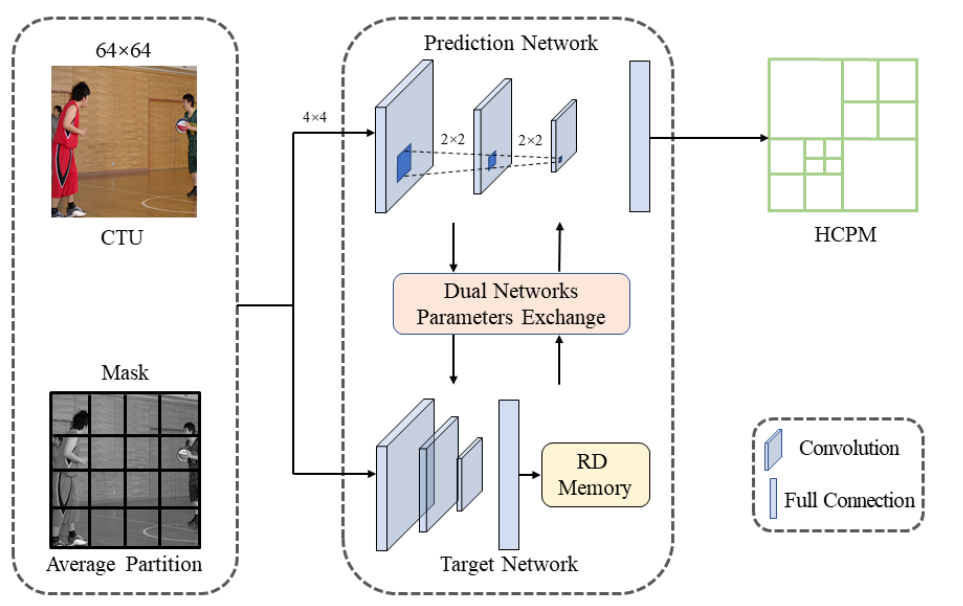
Figure 2. The overall pipeline of RDNet. The average partition mask is realized on the luminance matrix of original CTU. In addition, the convolution in prediction and target network contains one layer of 4 × 4 convolution and two layers of 2 × 2 convolution. The target network judges the best parameters by the RD memory, and optimizes the prediction network with the combination of the RD and classification loss.